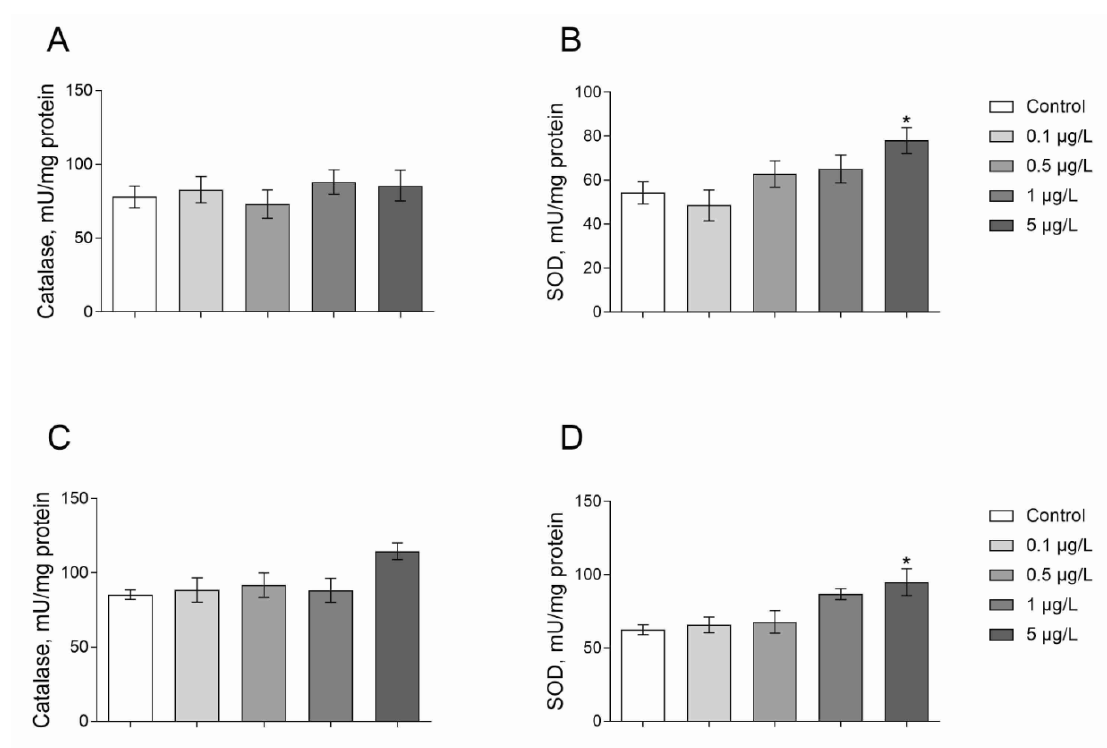
Figure 4: Catalase and SOD activities in D. magna exposed to Roundup ( A, B ) or Atrazine ( C, D ) for 24 hours. Values are expressed as mean ± S.E.M. (number of pools n = 3-6). *Significantly different with p < 0.05 (ANOVA followed by Dunnett’s multiple comparison